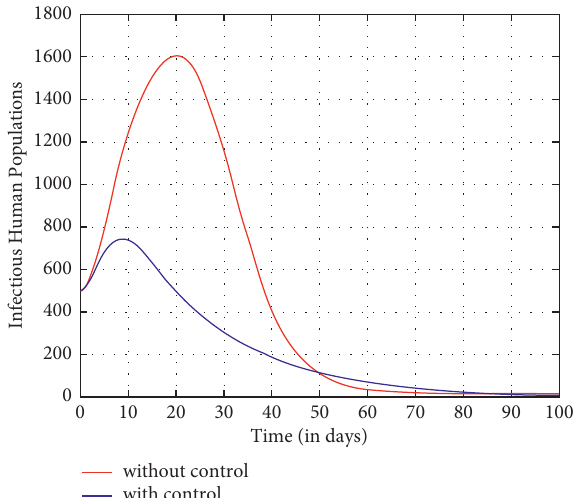
Figure 18: Infectious human population with and without control variable u .